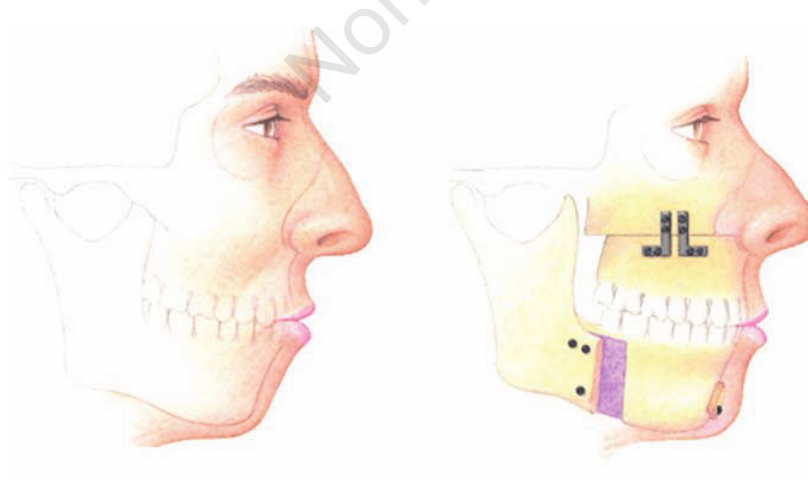
Figure 4. Reprinted with permission of the American Thoracic Society. Copyright (c) 2011 American Thoracic Society. Won C, Li K, Guilleminault C. Surgical treatment of obstructive sleep apnea: upper airway and maxillomandibular surgery. Proc Am Thorac Soc. 2008; 5: 193–199. Official Journal of the American Thoracic